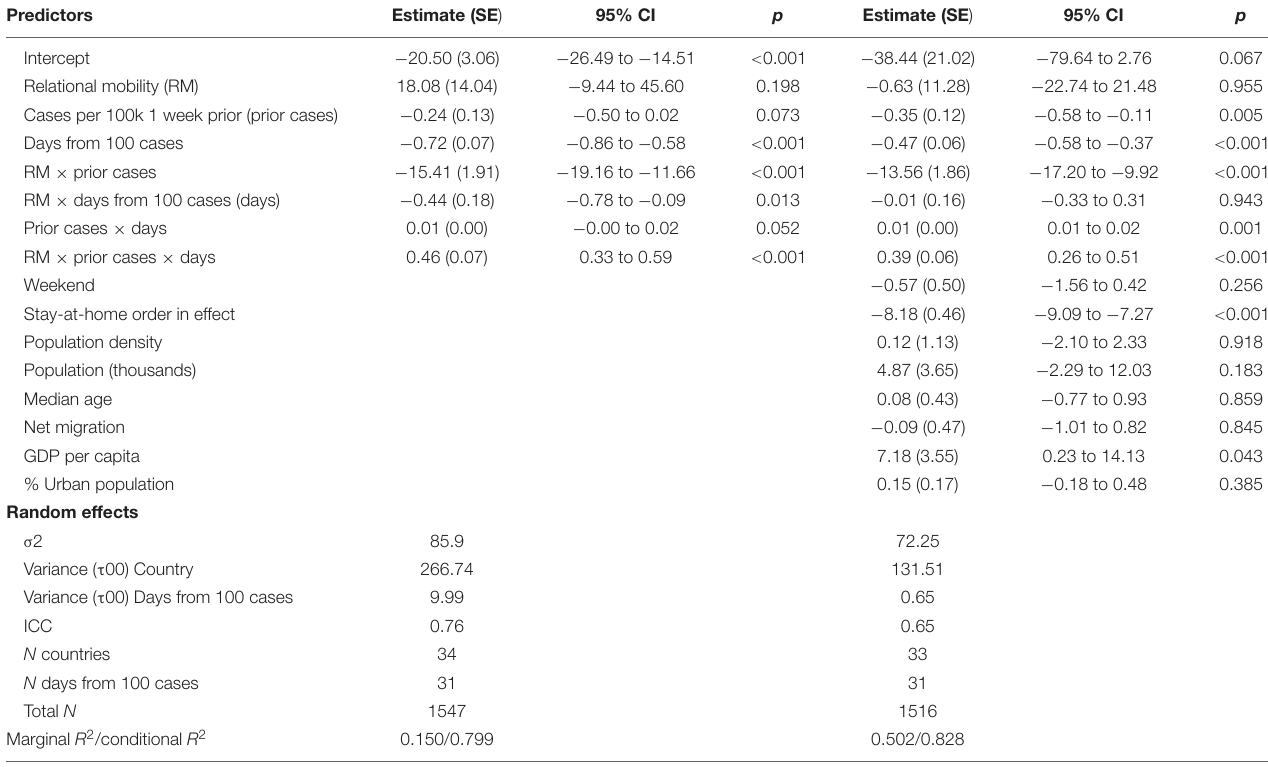
TABLE 6 | The impact of relational mobility and cases per 100,000 residents (lagged 7 days) on geographic mobility following the first 100 cases of COVID-19 in each country. Predictors Estimate (SE